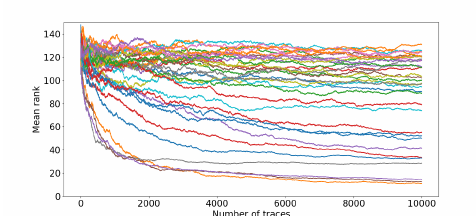
Figure 22: Guessing entropy of each individual CoL of TTSCA big from disjuncts of size equal to 4